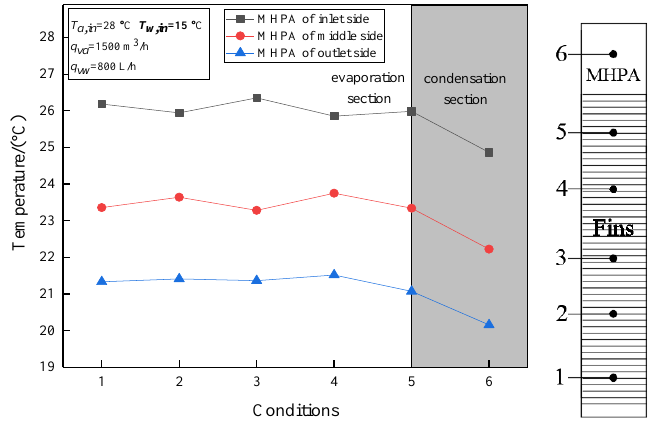
Figure 15. Temperature distribution of core components ( T w,in = 15 °C).